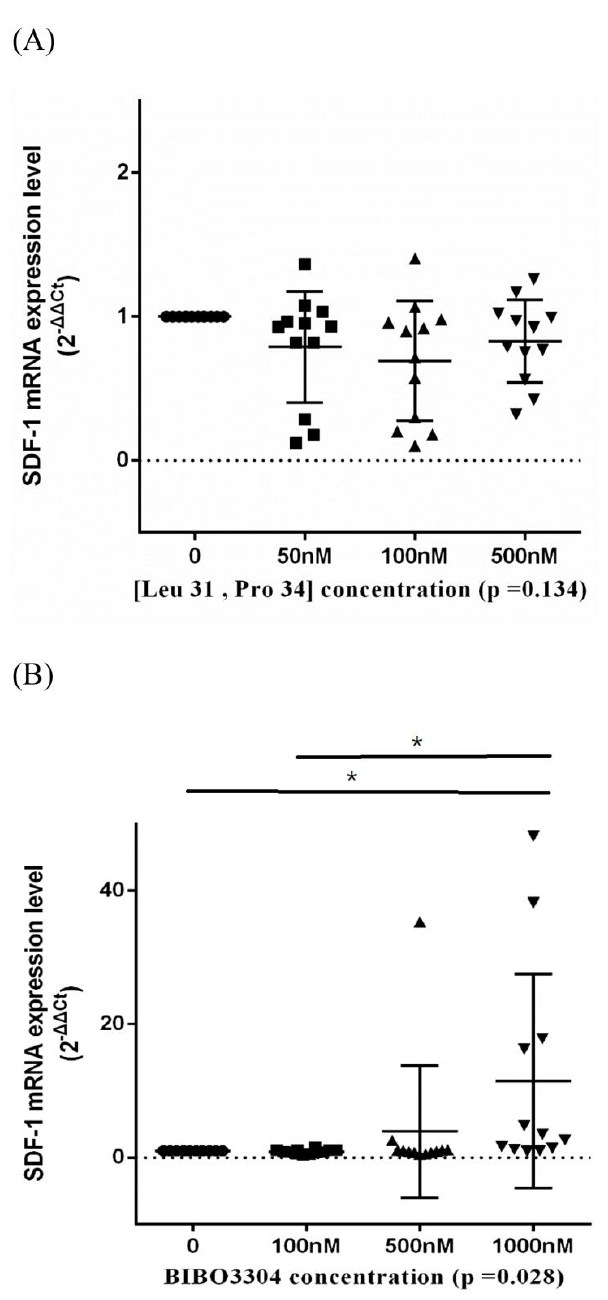
Figure 6. The transcription levels of stromal cell-derived factor-1 (SDF-1) of BMSCs treated in a serial concentration of Y1R agonist (Leu 31, Pro 34) ( A ) and antagonist BIBO3304 ( B ). Respective p -values for post-hoc analysis: ( B ) 0–1000 nM: 0.045; 100–1000 nM: 0.024 (* p < 0.05). The black triangles/dots/squares indicate the information concerning the respective SDF-1 mRNA expression levels for respective